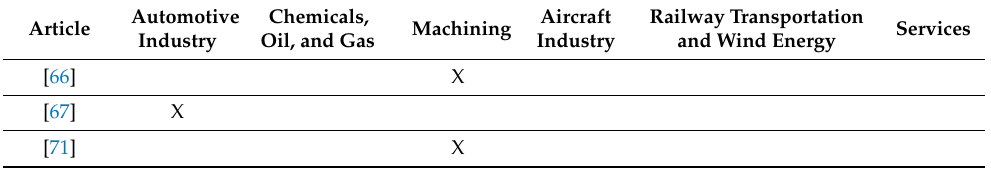
Table 2. Classification results of the “Applications” category. Source: Authors’